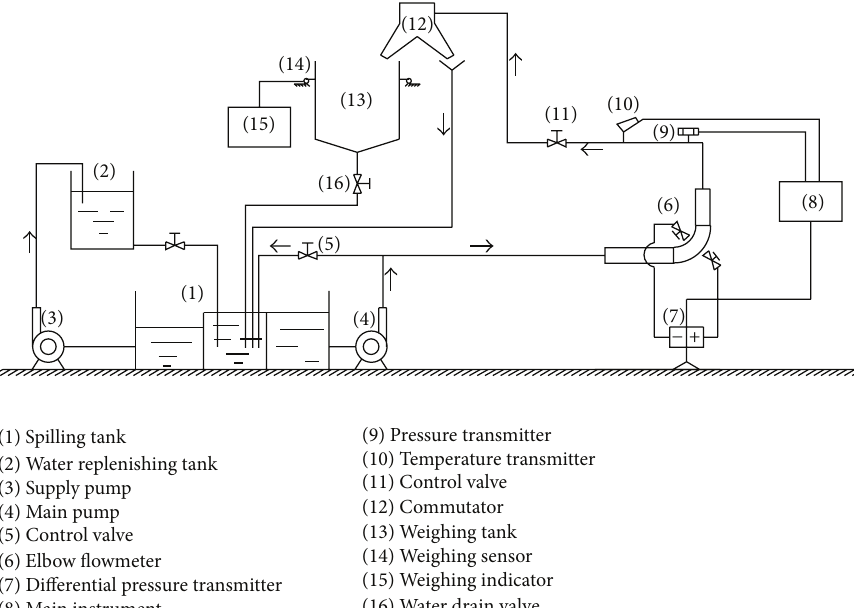
Figure 1: Schematic view of experimental setup for the wall pressure distribution measurement of intrados and extrados of 90 ∘ elbow.